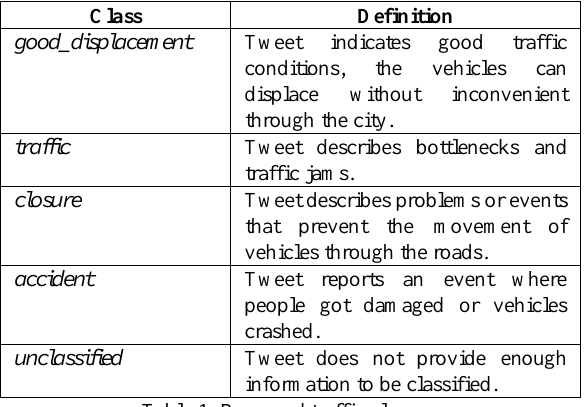
Table 1. Proposed traffic classes.